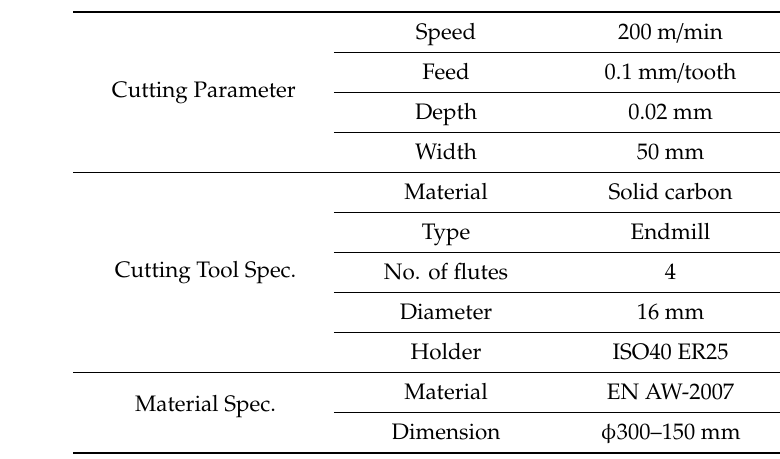
Table 3. Ballbar QC20-w specifications [33].